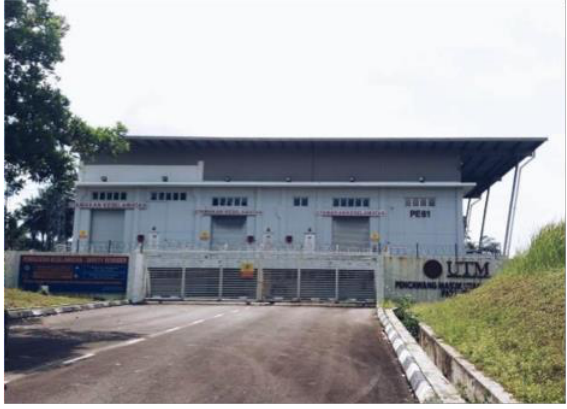
Figure 3: PE61 132/22KV Transmission Intake, UTM Johor Bahru, Malaysia